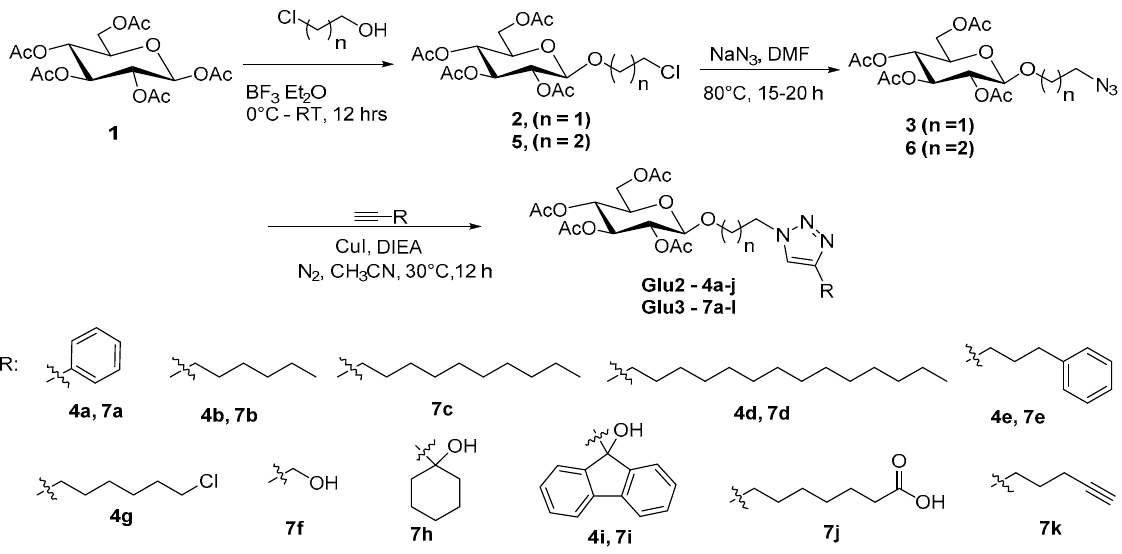
Figure 1. Structures of the glycosyl-triazole conjugates designed from the triazole derivatives with two ( Glu2 and Gal2 ) and three ( Glu3 and Gal3 ) carbon spacers.